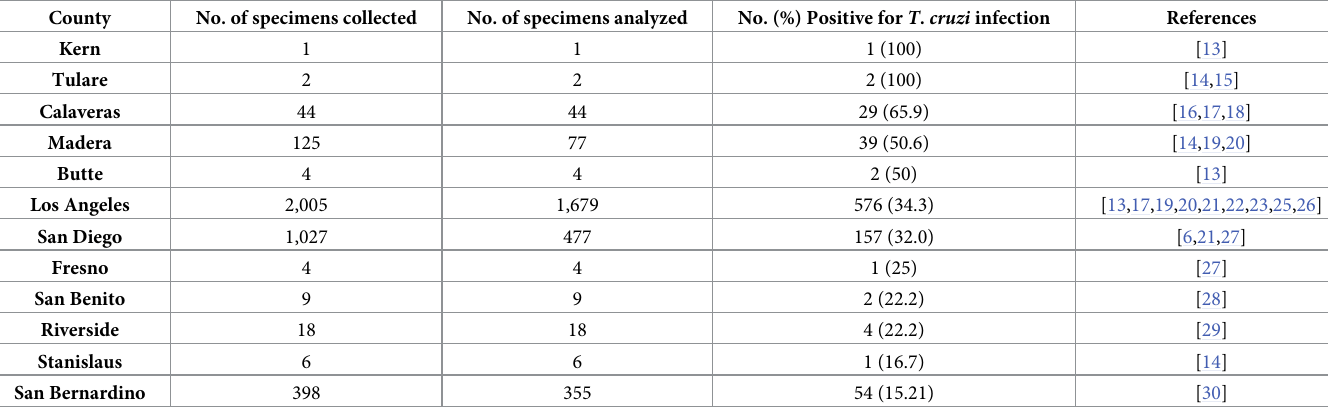
Table 2. Prevalence of T . cruzi infection among triatomines per county. County